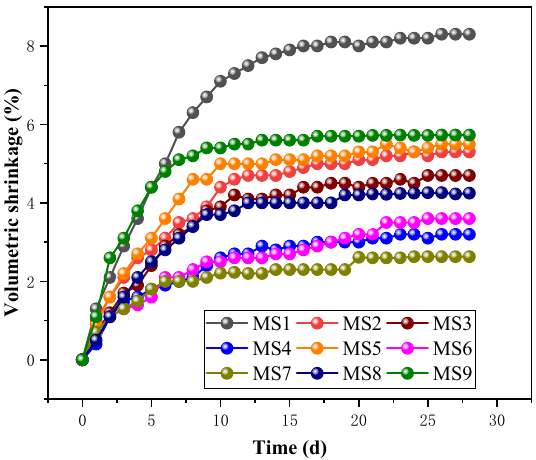
Figure 1. Volume shrinkage of modified dredged sludge samples.